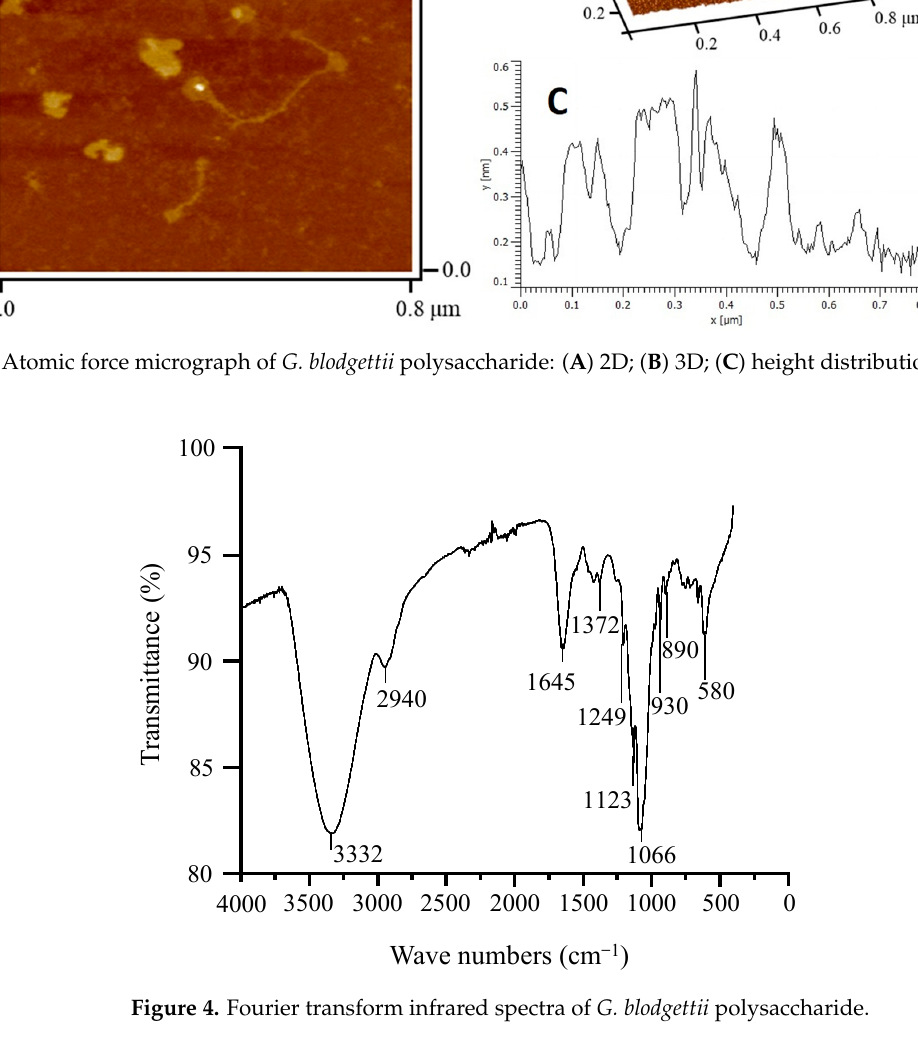
Figure 4. Fourier transform infrared spectra of G. blodgettii polysaccharide.